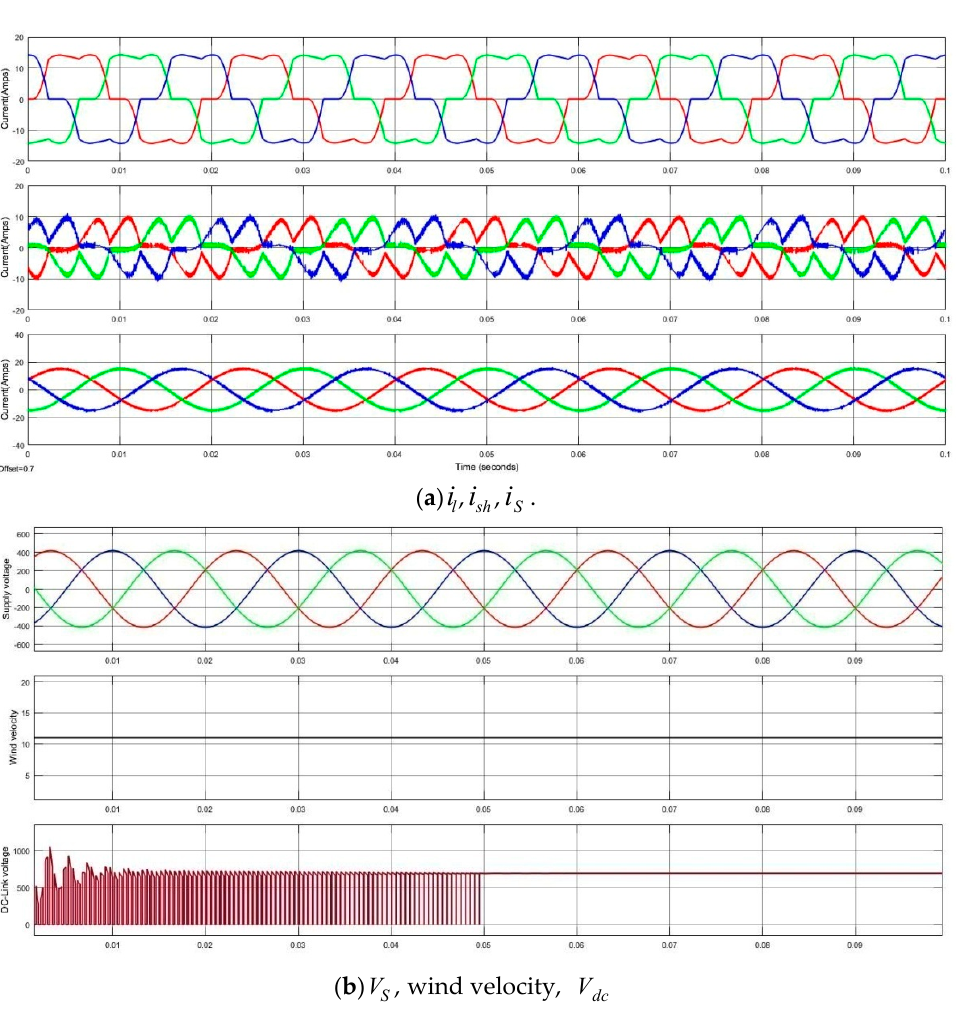
Figure 15. Waveforms for case 1.